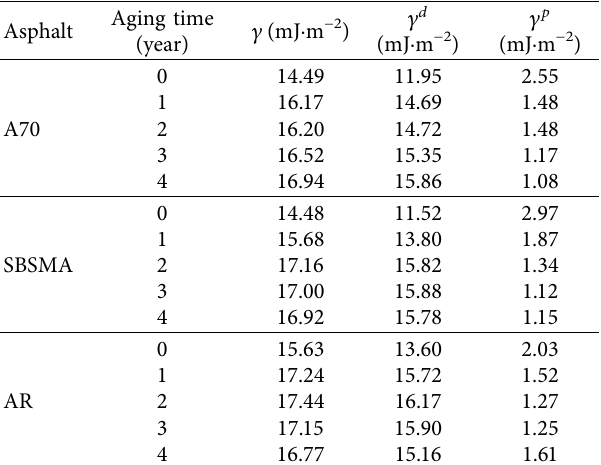
Table 6: Ductility dates of asphalt. Table 7: Surface free energy components of